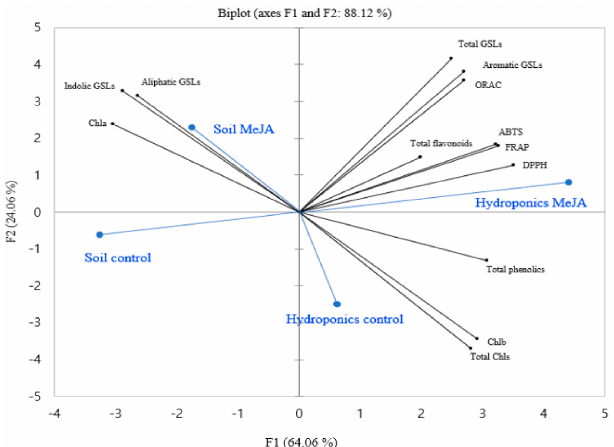
Figure 5. Biplot of the principal component analysis of the observed parameters of pak grown in soil or hydroponics with or without the treatment of MeJA. • Observed parameters •